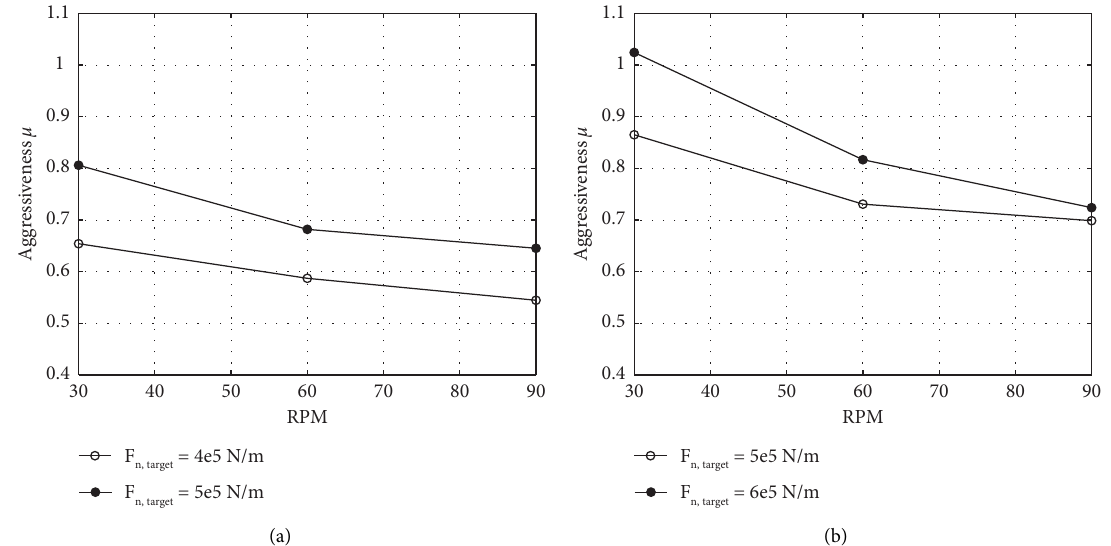
Figure 16: Efect of axial force using the models with cutting speed dependency on (a) normal bond strength and (b) grain